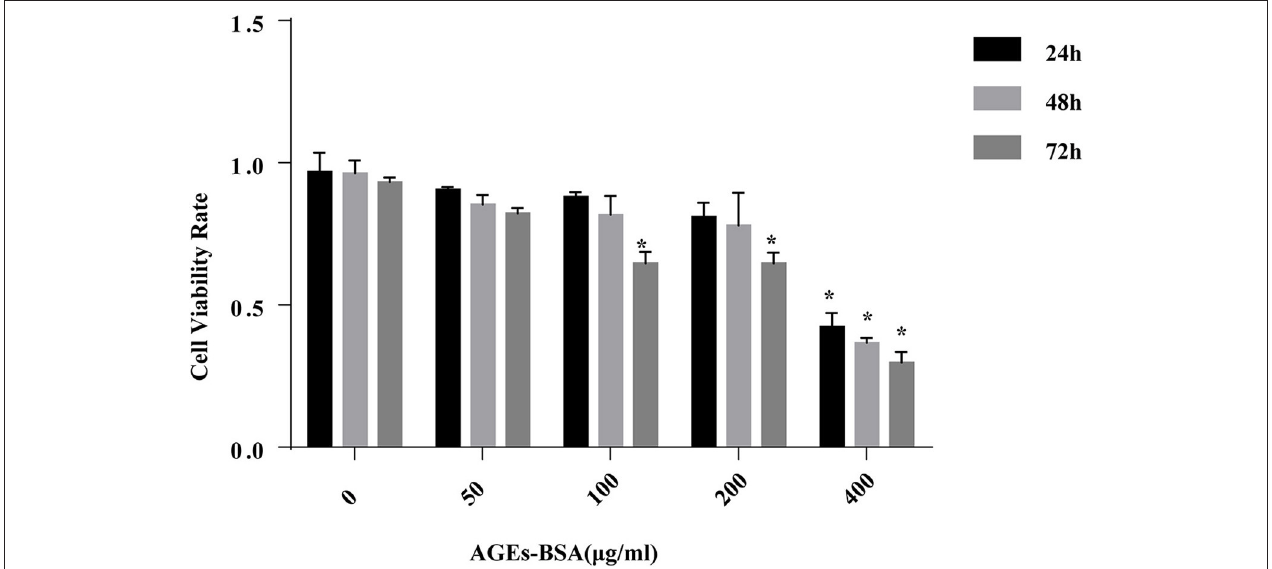
FIGURE 1 | Effects of AGEs-BSA on the viability of VSMCs. VSMCs were incubated with AGEs-BSA (0, 50, 100, 200, or 400 µ g/mL) for 24–72h. The percentage of viable cells was normalized to that of the control. * p < 0.05 compared to the controls.